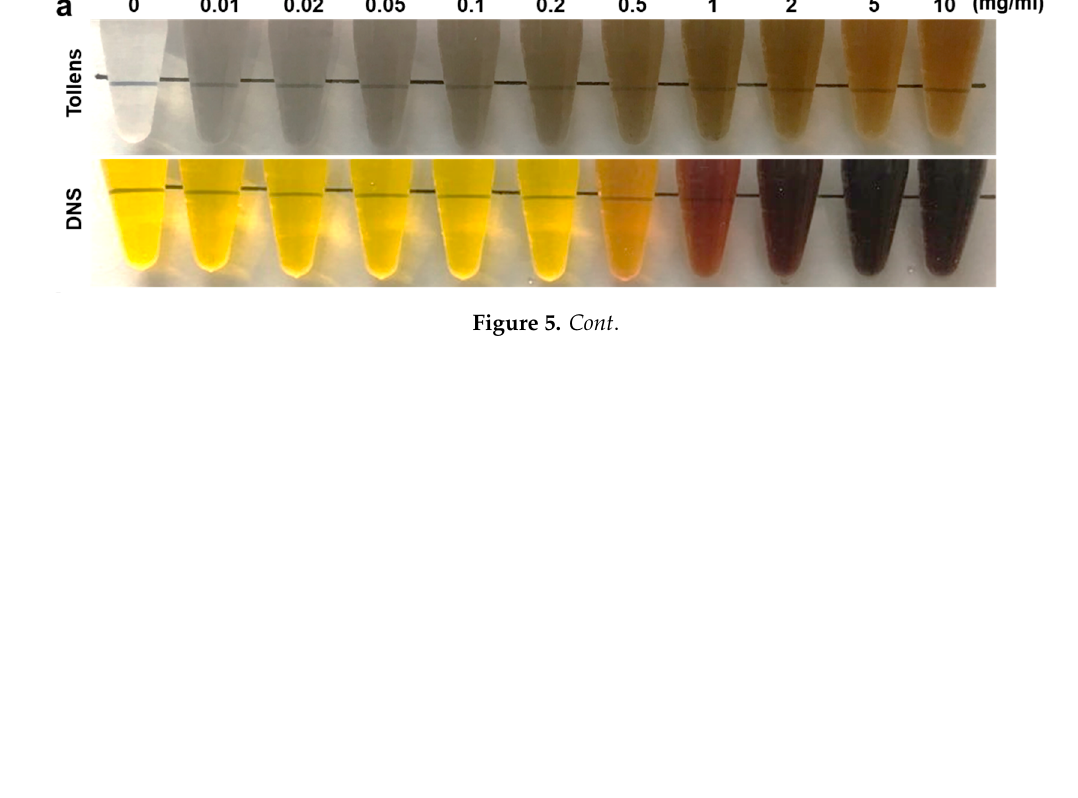
Figure 5. ( a ) Color development of the reaction as a function of concentration of debranched SCGs through modified Tollens’ reaction (top) and 3,5-dinitrosalicylic acid (DNS) reaction (bottom). ( b ) UV- vis absorption spectra showing the characteristic absorption peaks of AgNPs regardless of the concentration of debranched SCGs. The inset is a magnified view of the absorption spectra of AgNPs formed at the lower concentrations of SCGs. ( c ) Calibration curves for the quantitative determination of debranched SCGs through the modified Tollens’ reaction (hollow square) and DNS method (filled square). The dotted line represents the SPR absorption spectrum of AgNPs formed without SCGs (control). A curve was fitted for nonlinear regression using a sigmoidal function. 3.4. Investigation of the Debranching Reaction in a Real Sample The feasibility of the proposed detection system for monitoring the progress of a debranching reaction was further investigated by using a real sample. An enzymatic debranching reaction was carried out using waxy maize starch (1 mg/mL) and 1.0 APSU/mL of pullulanase, and an aliquot of the sample was taken from the reaction at a given time point over the course of 48 h reaction. Figure 6a presents the SPR absorption spectra of AgNPs formed with the sample taken from the debranching reaction at each time point. The results showed that the intensity of the SPR absorption peak at 426 nm gradually increased with the progression of the debranching reaction (Figure 6a). The intensity of the absorbance peak from the reaction was converted to the amount of SCG based on the calibration curves obtained from the modified Tollens’ reaction and DNS assay, respectively. According to the plot of SCGs vs. debranching time (hours), the debranching reaction reached a plateau at around 24 h from the beginning of the reaction, suggesting that all the branches in the amylopectins of waxy maize starch were hydrolyzed at the given condition. The profile of the SCGs estimated by DNS assay with the same sample showed a similar trend, but the amplitude of the signal was notably lower, particularly at the early stages of the reaction, in comparison to that of the modified Tollens’ reaction (Figure 6b). The debranching activity of pullulanase was evaluated using a first-order kinetic model [1]. The modified Tollens’ reaction showed a higher debranching rate constant ( k = 0.237) than the DNS assay ( k = 0.163) (Figure S5). Considering the higher sensitivity and greater fitting nature of the plot, we believe that the rate constant of the modified Tollens’ reaction would be more accurate to represent the debranching activity of DBEs. These results support that the modified Tollens’ reaction proposed in this work provides a simple, sensitive and accurate means of monitoring the activity of debranching enzyme and the progress of the reaction.